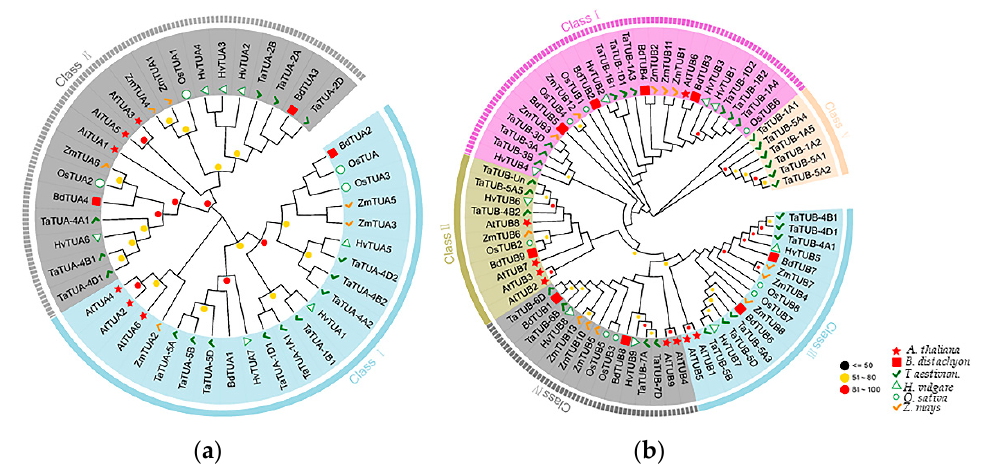
Figure 3. Evolutionary relationships of plant TUA and TUB genes. ( a ) Evolutionary relationships of TUA genes. ( b ) Evolutionary relationships of TUB genes. The evolutionary history was inferred using the Neighbor-Joining method. The evolutionary distances were computed using the JTT matrix-based method.